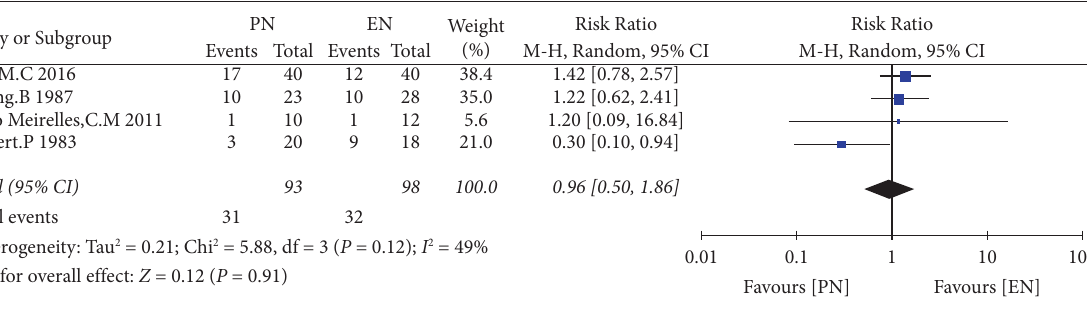
Figure 3: Te direct comparison of in-hospital mortality between the EN group and the PN group.